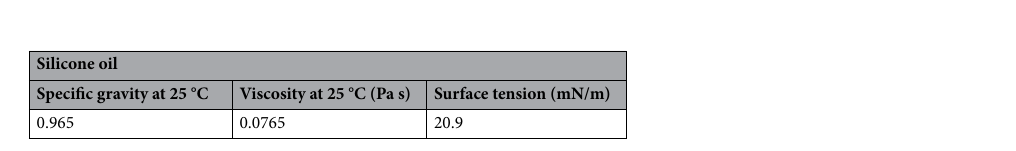
Table 2. Properties of working fluid, silicone